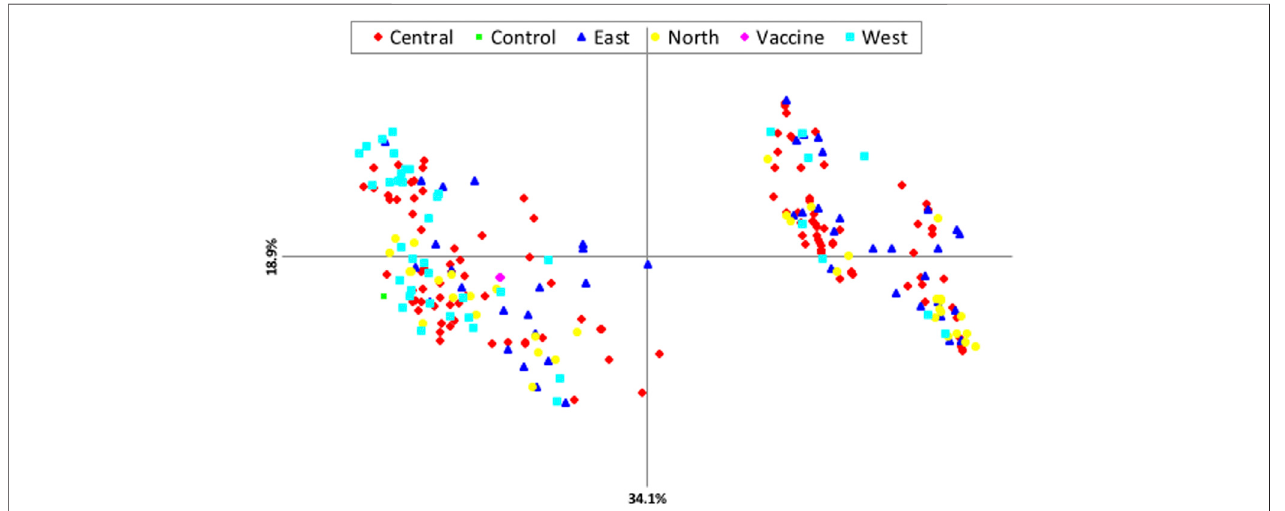
FIGURE 2 | Principle component analysis (PCA) showing the genetic structure of T. annulata populations from the four regions of Sudan.